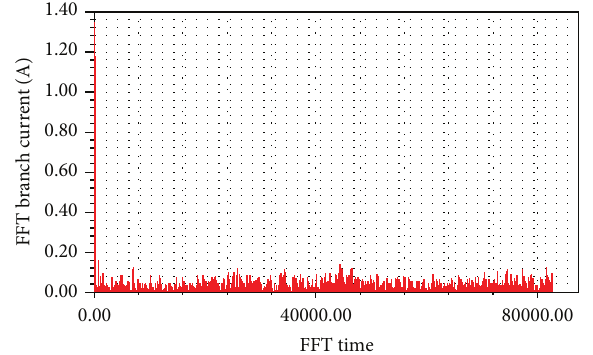
Figure 30: The FFT of DC link current in hysteresis control mode (without passive filter).